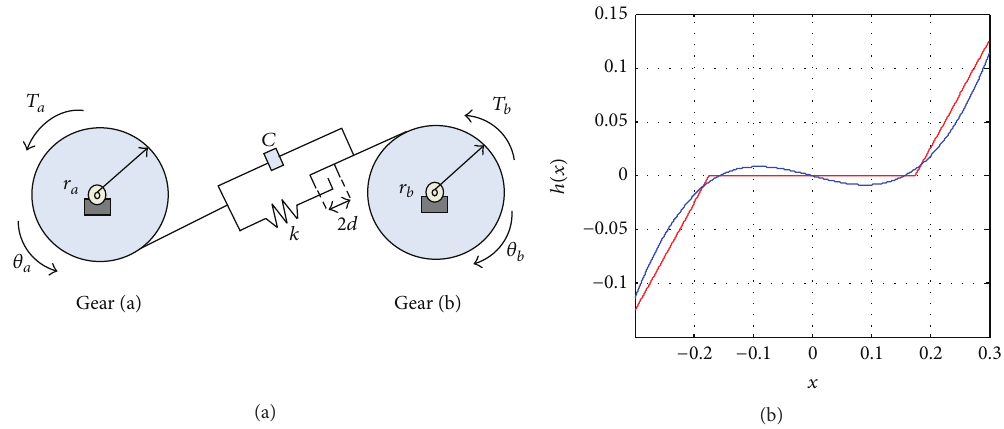
Figure 1: (a) A gear pair model and (b) the approximation of ℎ(𝑥) based on a third-order polynomial.